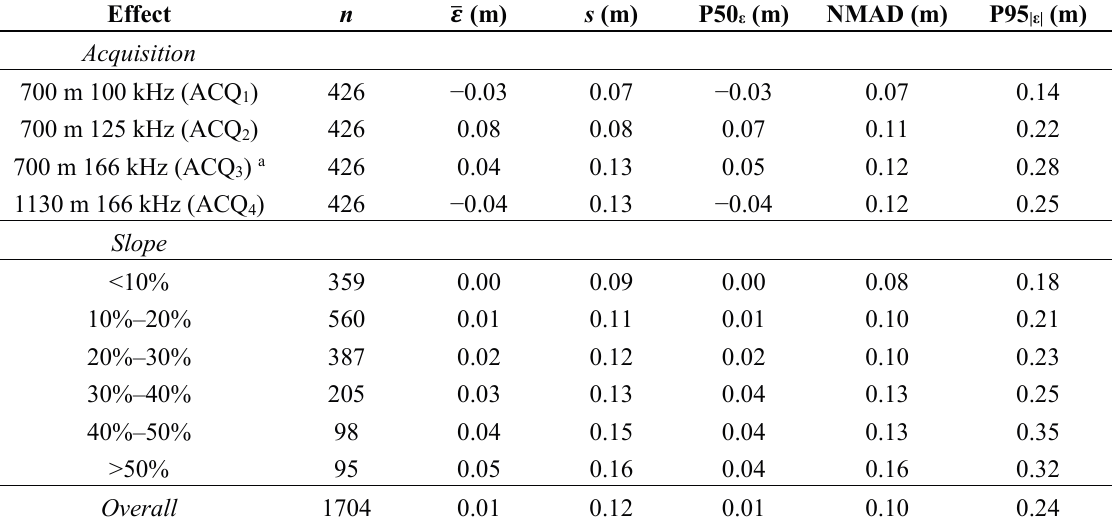
Table 3. Mean error of TIN surface elevation ( (cid:2013)̅ ), standard deviation of the errors ( s ), 50% quantile of the errors (P50 ε ), normalized median absolute deviation (NMAD), and 95% quantile of the absolute value of the errors (P95 | ε | ) for different acquisitions and terrain